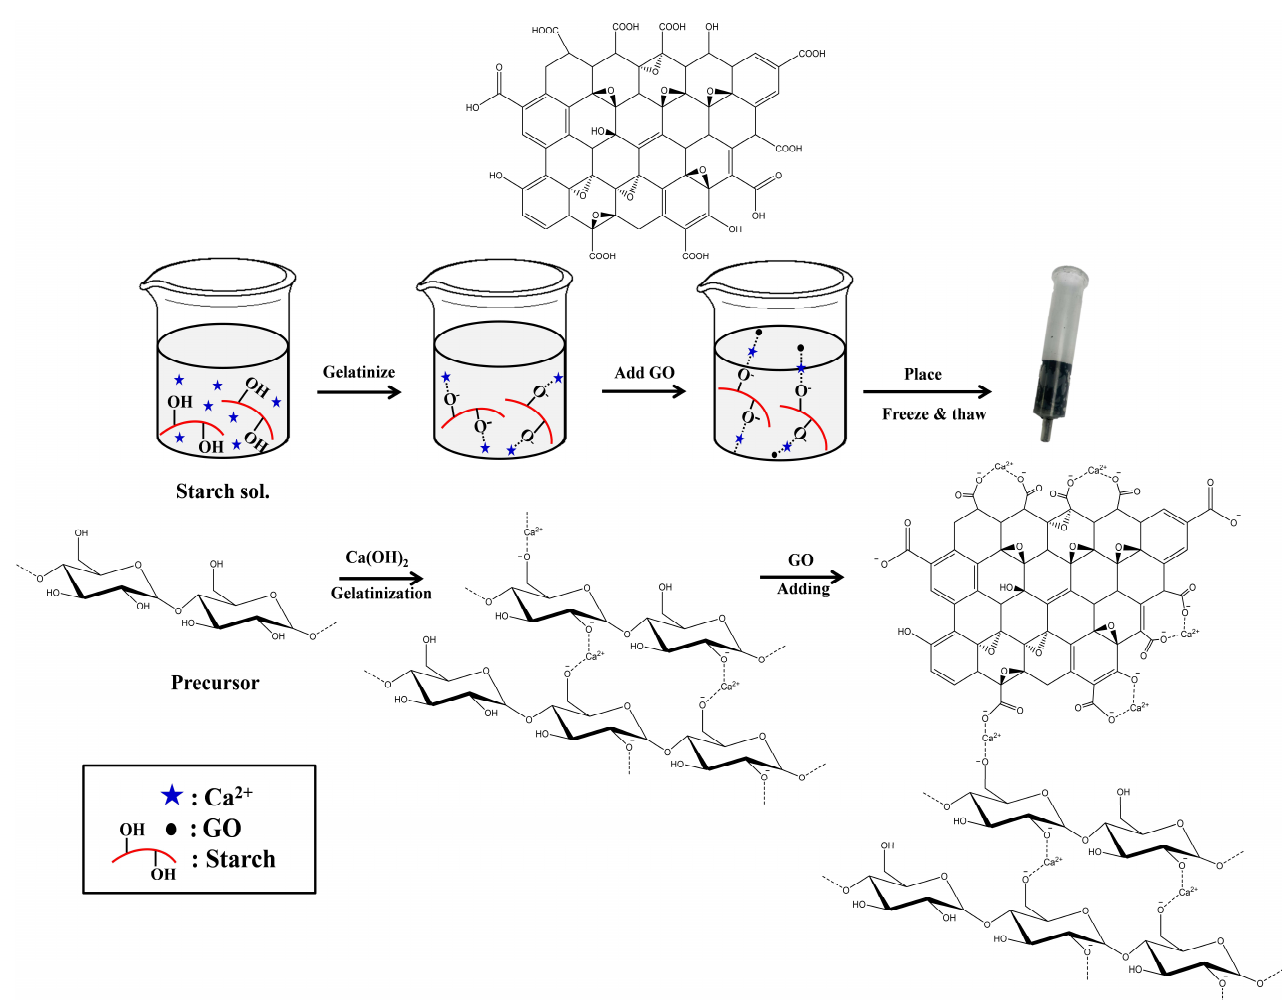
Figure 1. Proposed mechanism for preparation of GO-Cry.